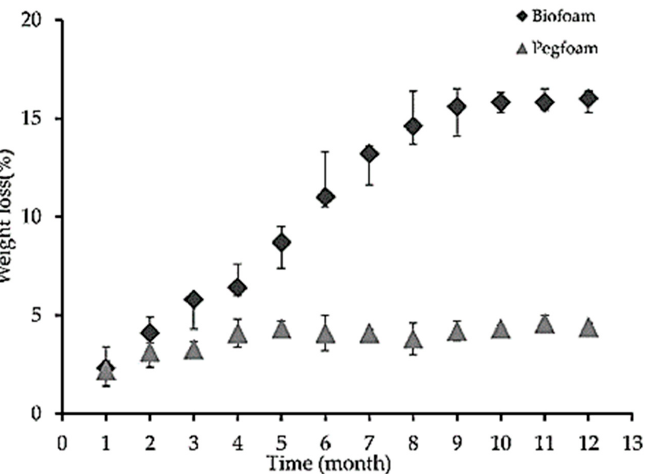
Figure 11. Weight loss of polyurethane samples over time in biodegradation experiments [88] .